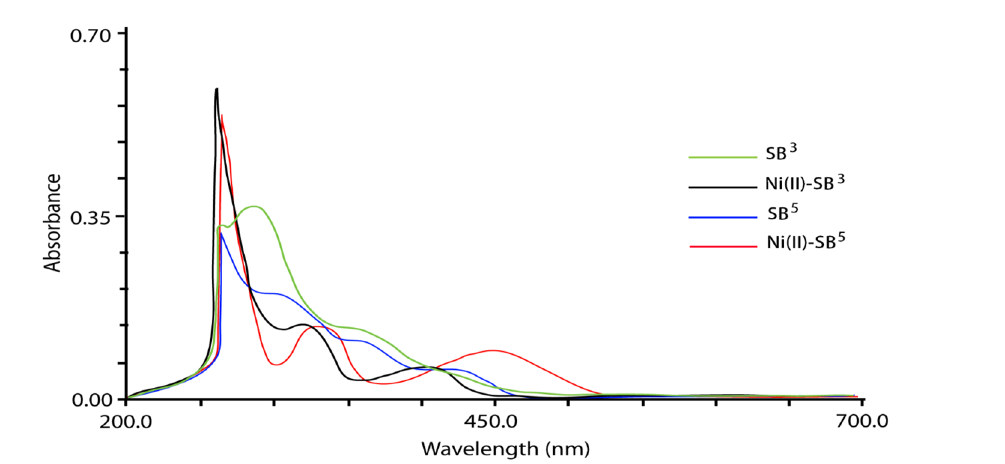
Figure 9. UV–Vis absorption band of SB 3 and SB 5 ligands and their